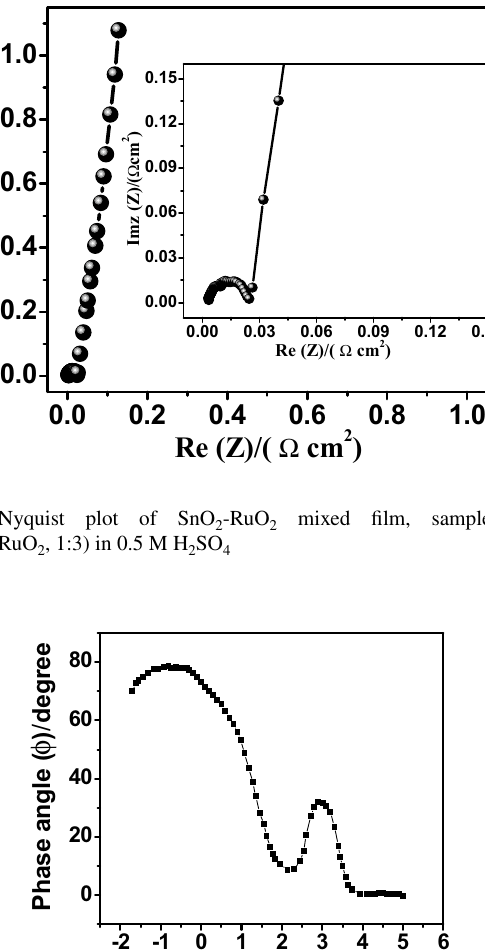
2 -RuO 2 mixed film, sample S3 (SnO 2 :RuO 2 ,